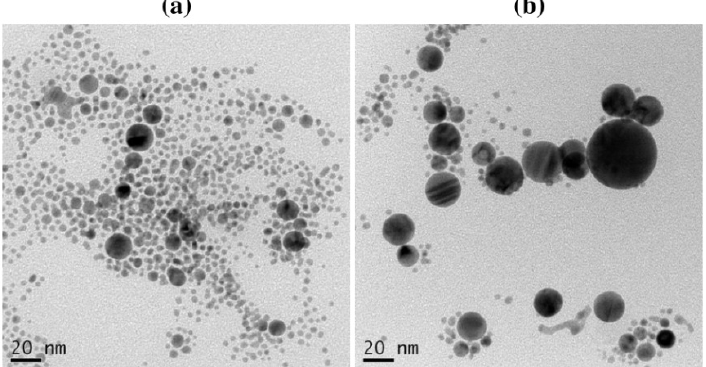
Figure 10. The TEM images of Au NPs with TX-100 after ( a ) preparation and ( b ) storing for 7 days. Conditions: TX-100 concentration = 10 mM, laser fluence = 0.4 J cm −2 , and ablation time = 40 min.